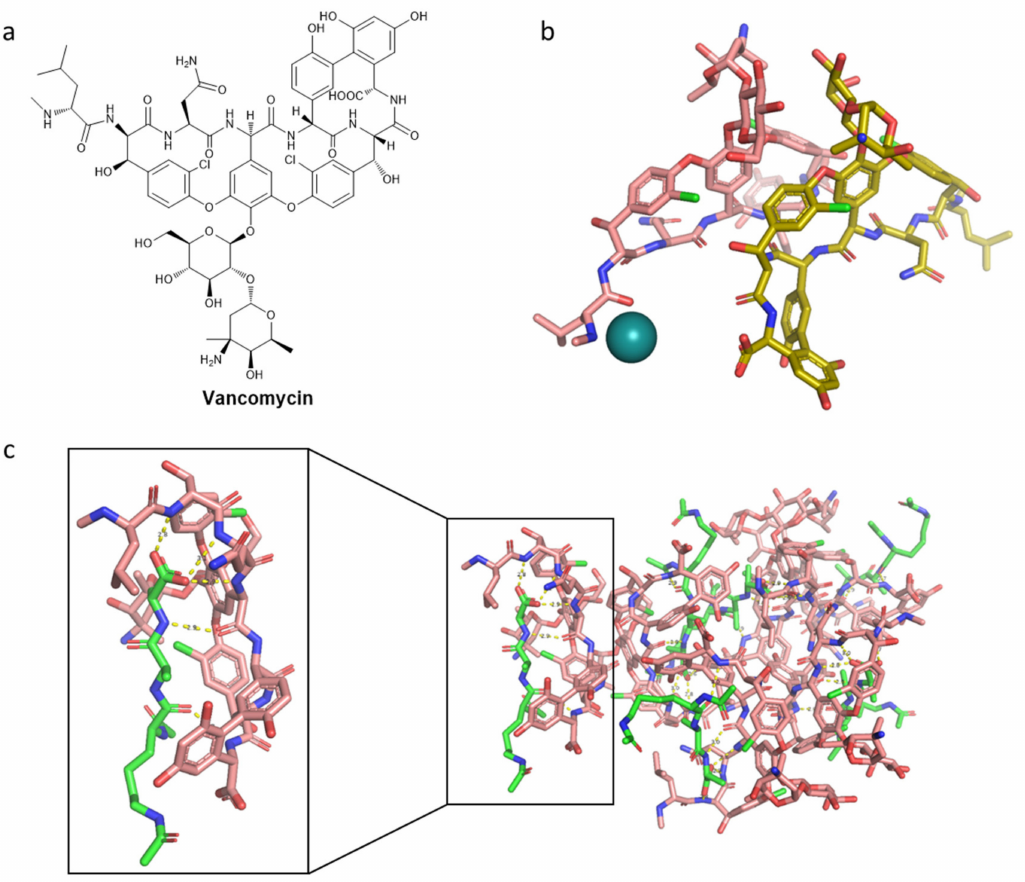
Figure 7. ( a ) 2D structure of vancomycin. ( b ) PyMOL 3D structure of two vancomycin molecules with a Zn 2+ ion (PDB code 5M2K, ethanediol was removed); ( c ) 3D representation of the complex of vancomycin (colored in salmon) and D -Ala- D -Ala (in green, PDB ID: